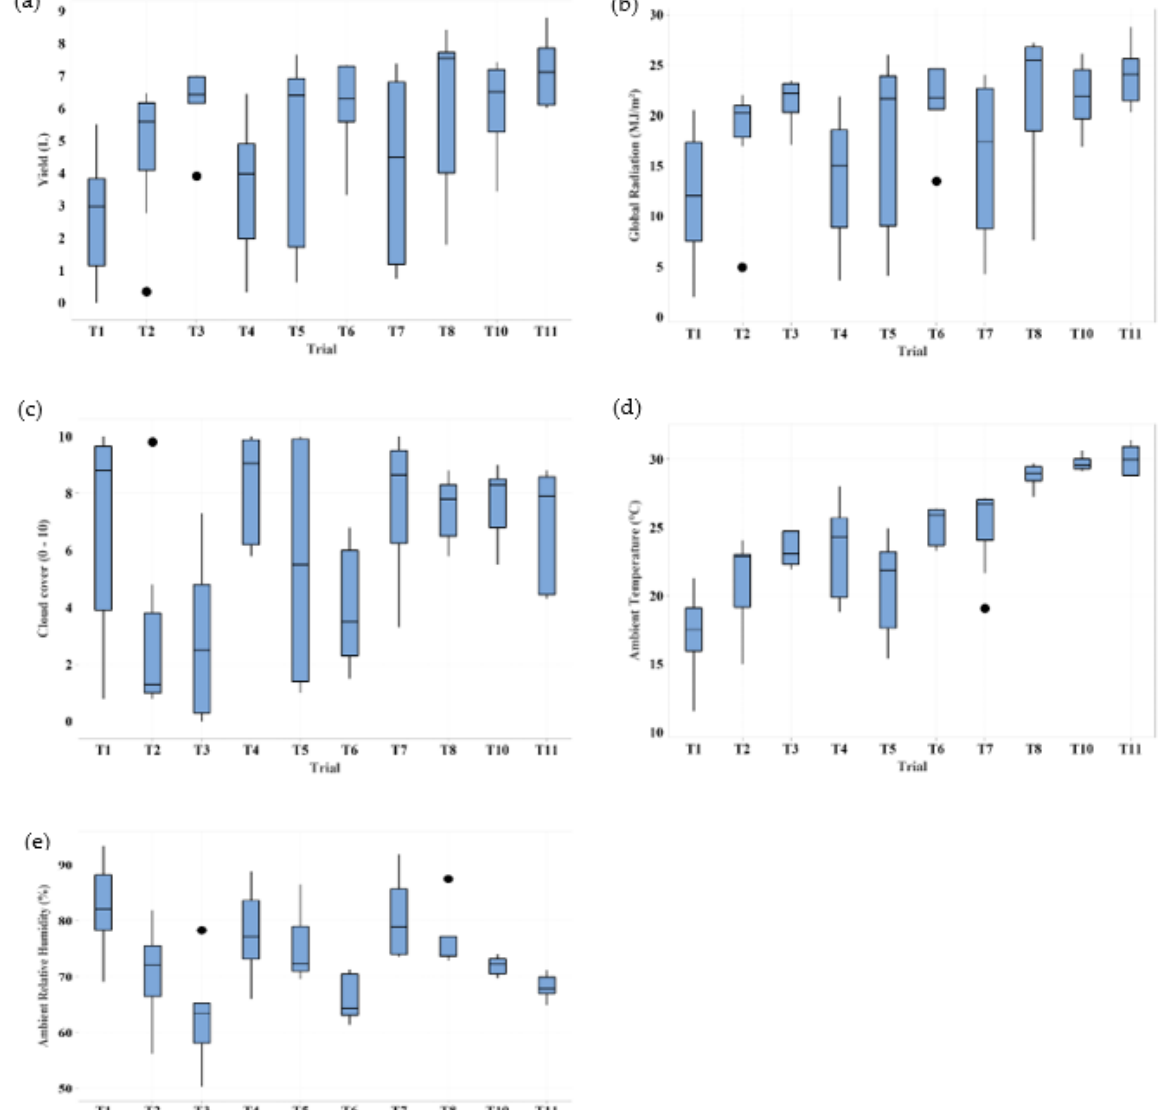
Figure 5. Identification of outliers within the Guiren experimental data sets of: ( a ) yield; ( b ) solar radiation; ( c ) cloud cover; ( d ) ambient temperature; ( e ) ambient relative humidity (NB: the shaded dots represent the outliers).